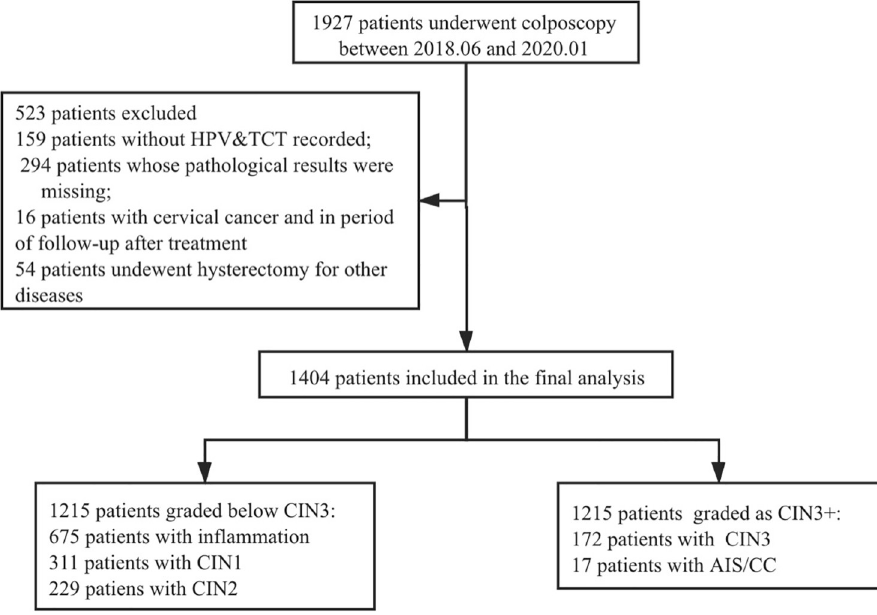
Fig 1. Flowchart of patients. Abbreviations: HPV, human papillomavirus; TCT, liquid-based cytology test; CIN, cervical intraepithelial neoplasia; CIN3+, CIN3/AIS/CC; AIS, adenocarcinoma in situ; CC, invasive cervical cancer.